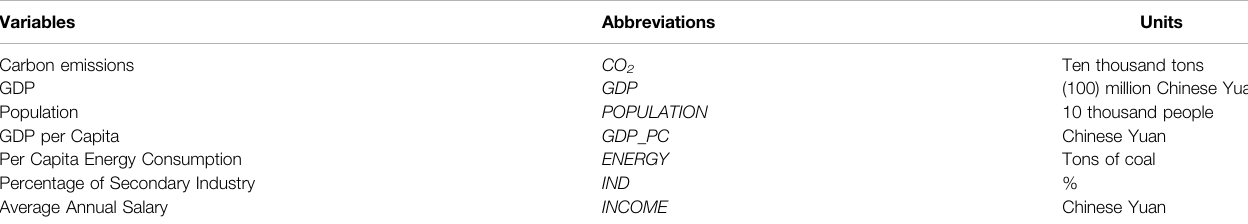
TABLE 1 | Variables description.